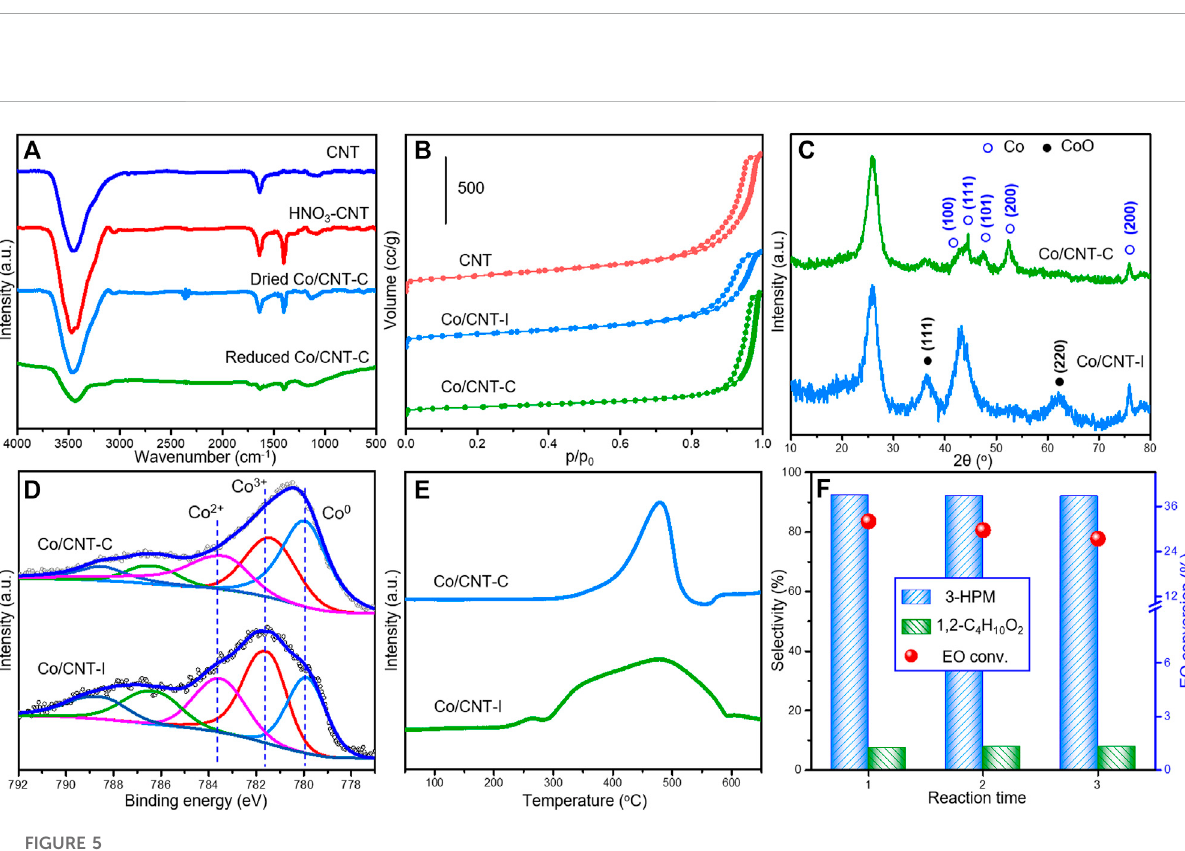
– desorption curves, (C) XRD patterns, (D) XPS spectra of Co 3 d 2 adsorption